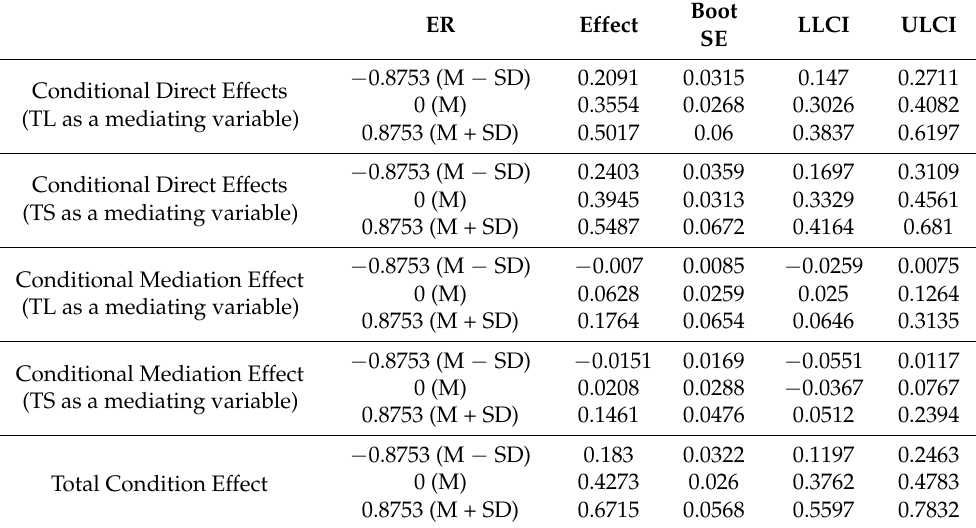
Table 8. Test results of direct, mediated, and total effect paths of environmental